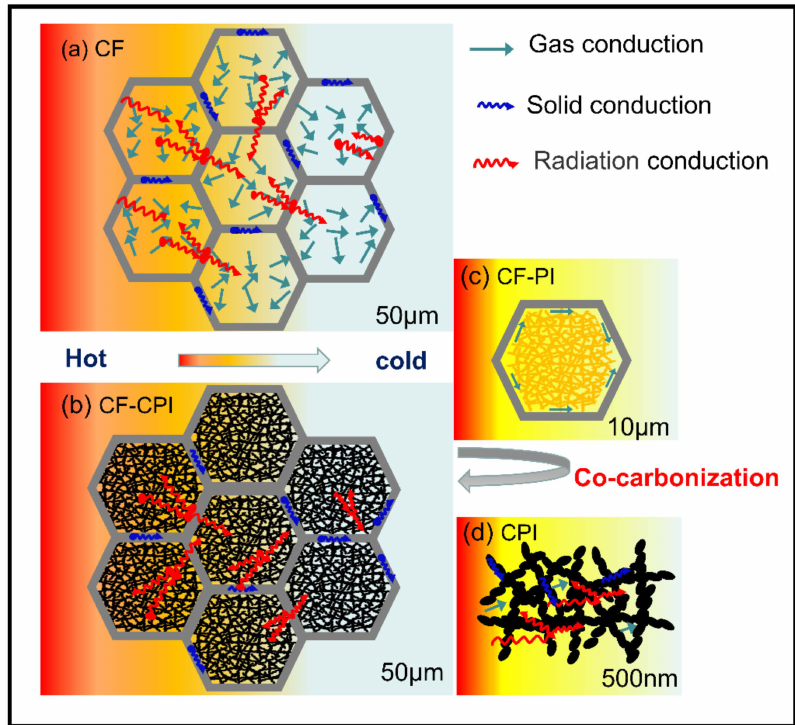
Figure 9. Schematic illustration of heat transfer mechanism ( a ) CF, ( b ) CF-CPI, ( c ) CF-PI, ( d ) CPI.